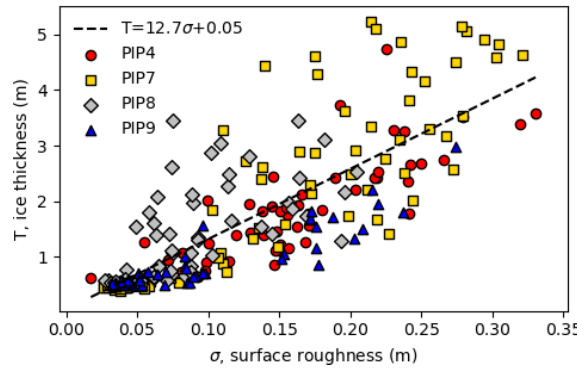
Figure 6. Predicting mean ice thickness with just the surface rough- ness ( σ ) as the input, with MRE 33%. The best-fit line is also shown, with R 2 = 0 . 65.